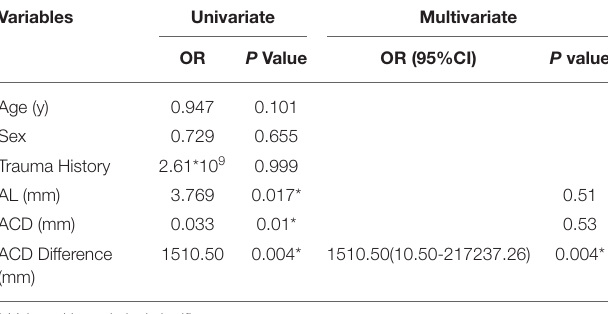
TABLE 4 | Univariate and multivariate logistic regression analysis for the identification of risk factors of acute secondary angle closure, associated with lens